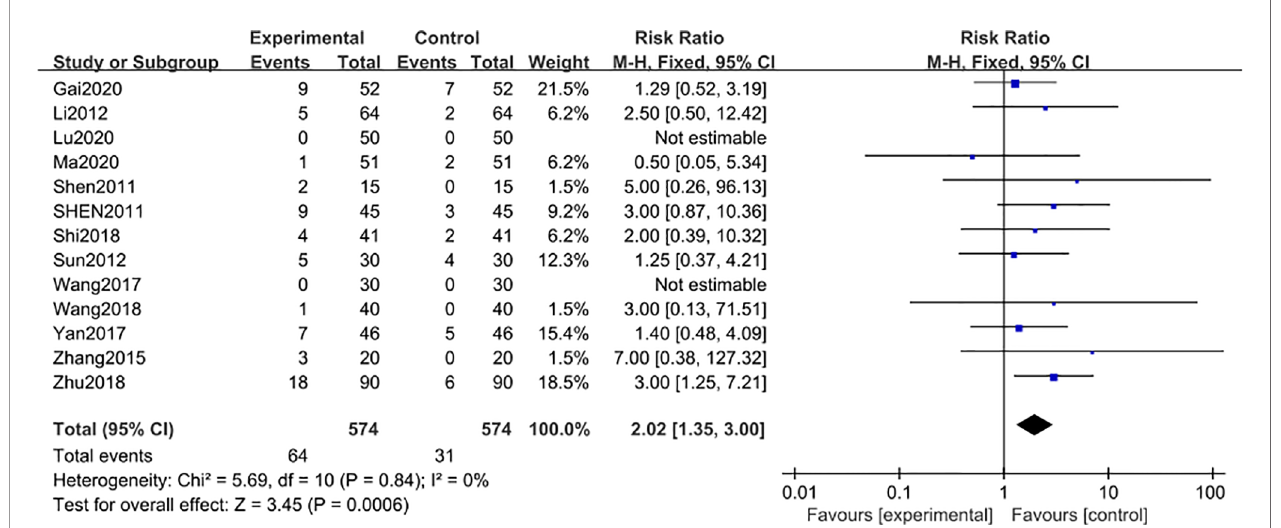
FIGURE 6 | Adverse reaction events after 3 months: comparison of treatment combined with TG against basic treatment.